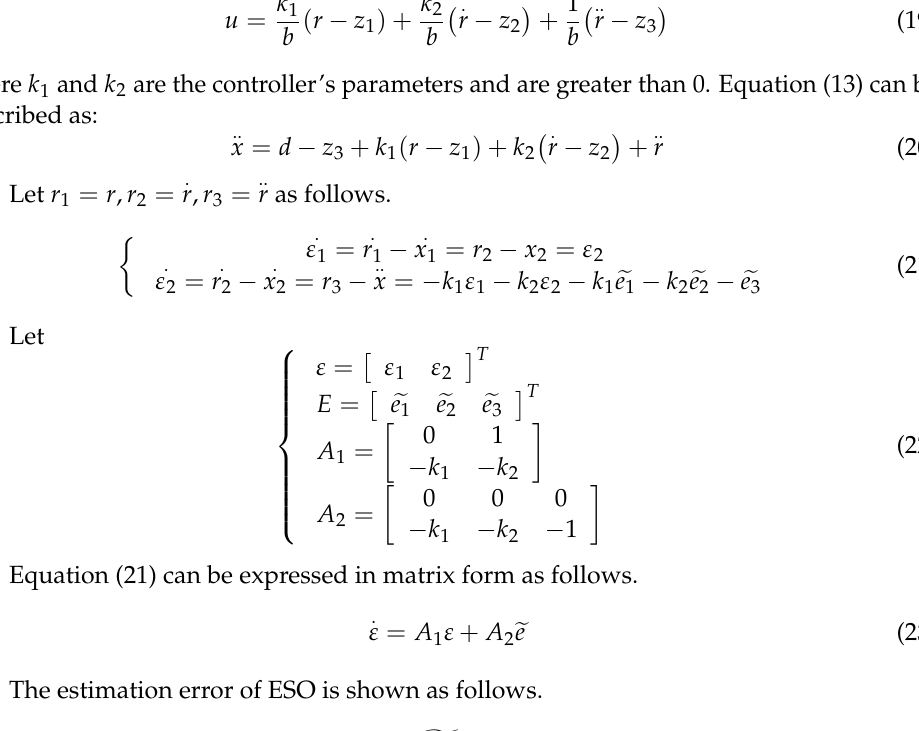
Figure 6. Block diagram of the ADRC structure with LuGre friction compensation.